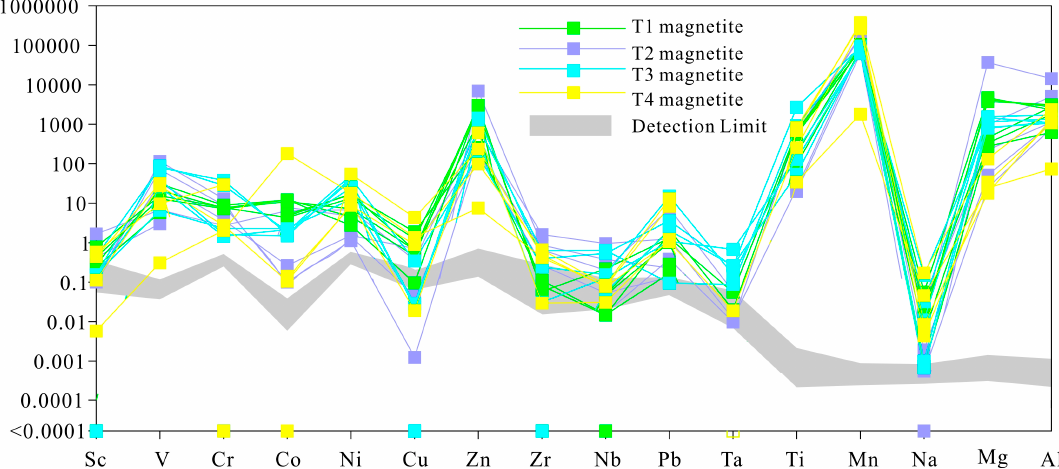
Figure 5. LA-ICP-MS analytical results from magnetite of Huanggangliang deposit, which are compared to the instrument limits of detection.